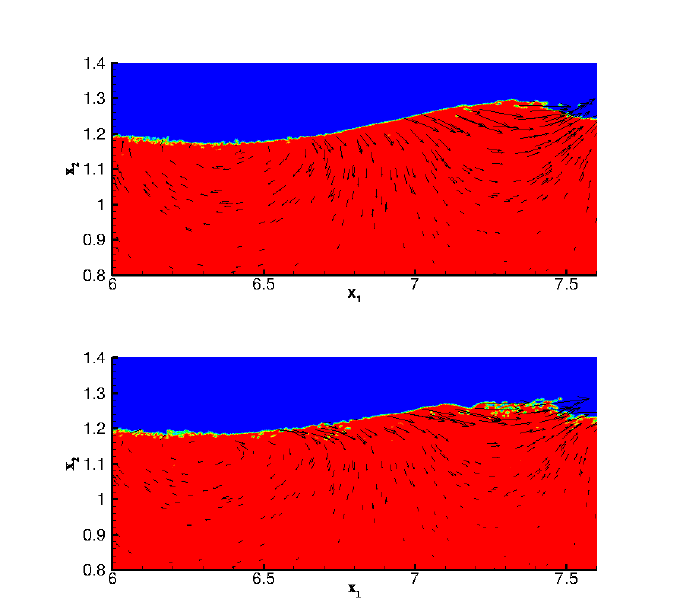
Figure 3. Instantaneous snapshot of the water volume fraction α w at the time t = 7 [s] superposed with the velocity vectors for the case with wind body force f = 0.5 [N/M] ( top panel ), the case with the wind body force f = 0.6 [N/M] ( bottom panel ).